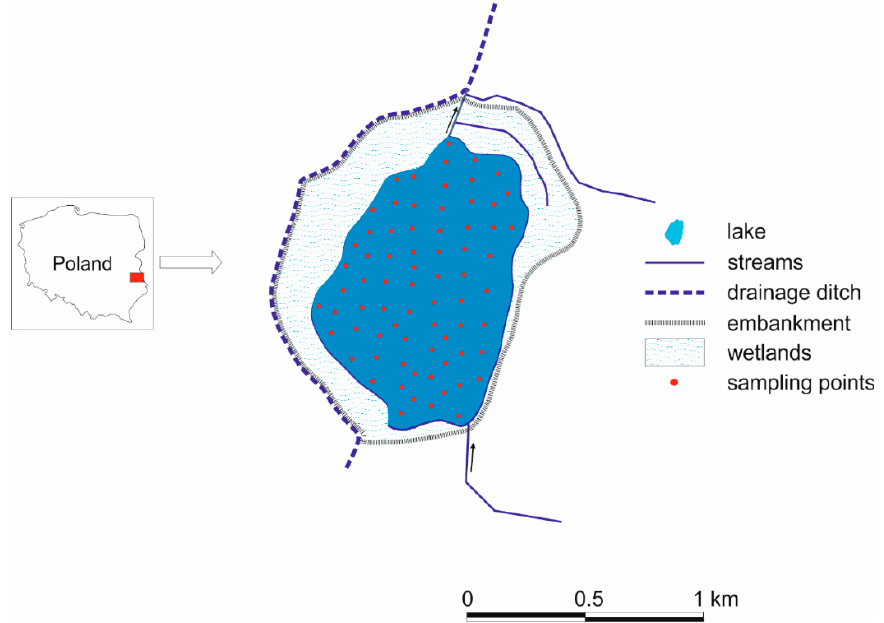
Figure 1. Location of the lake under study.